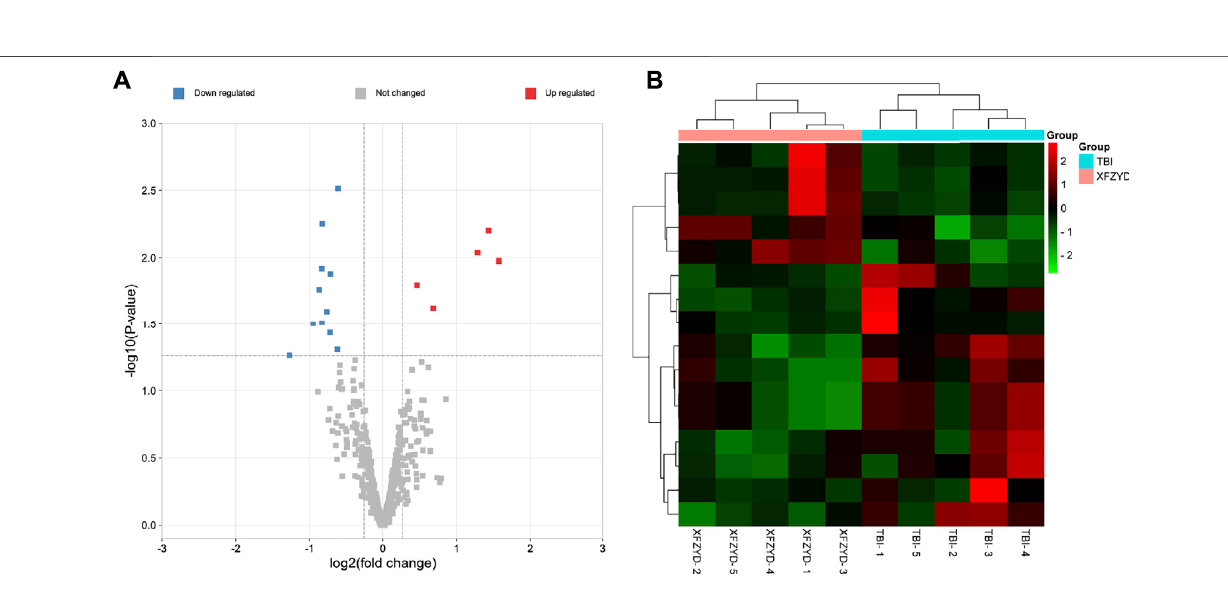
Frontiers in Pharmacology |